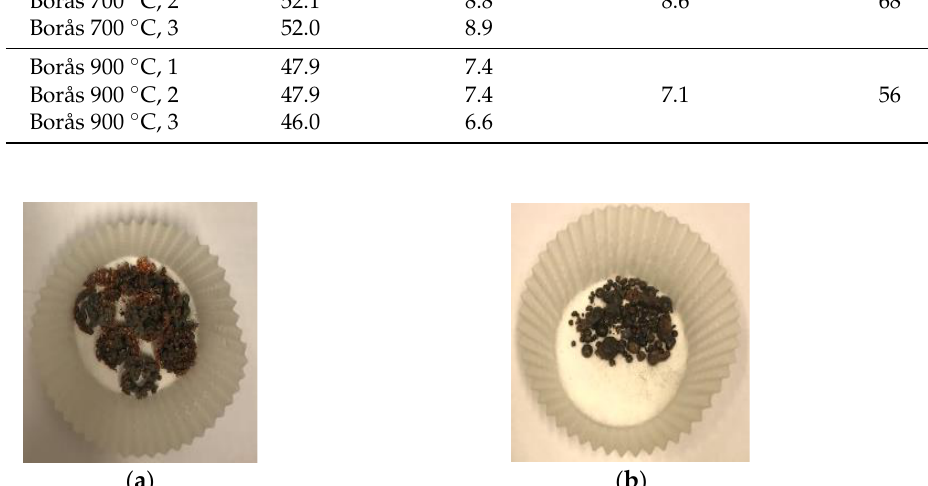
Figure 5 . ( a ) Borås sludge sample before pyrolysis, ( b ) Char after pyrolysis at 500 °C, ( c ) 700 °C, and ( d ) 900 °C.